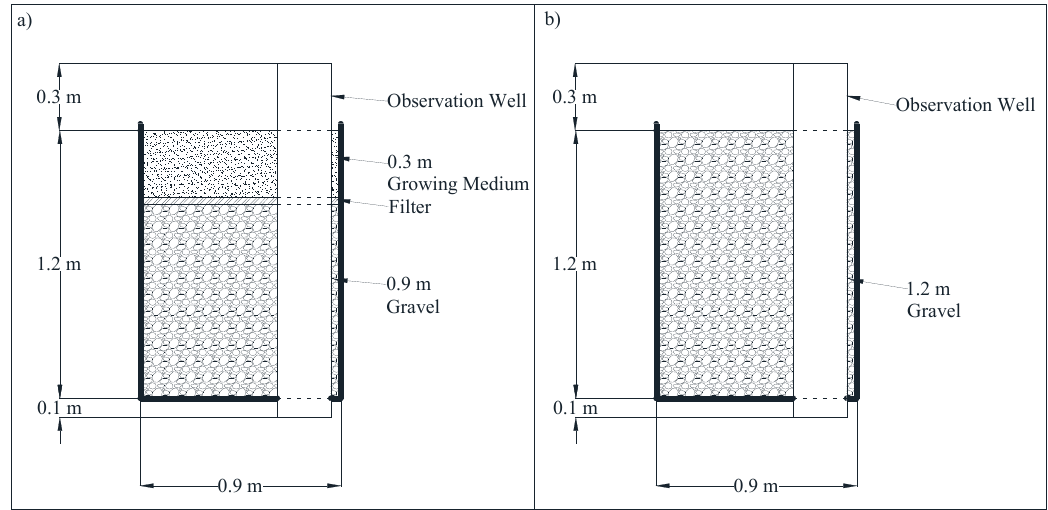
Figure 4. Linear BMP cross section: ( a ) bioswale; ( b ) infiltration trench.